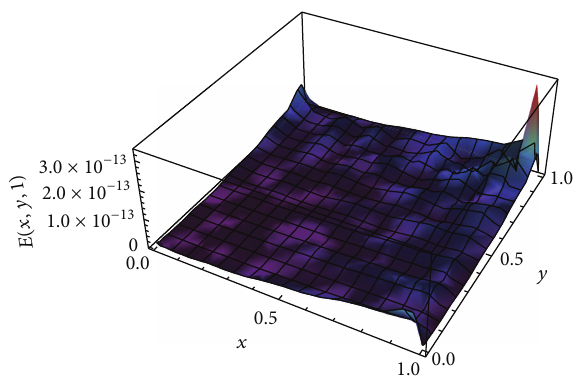
Figure 8: 𝑦 -direction curves of absolute error of problem (46) at = ] = 1.5 and 𝑁 = 𝑀 = 10 ] 1 2